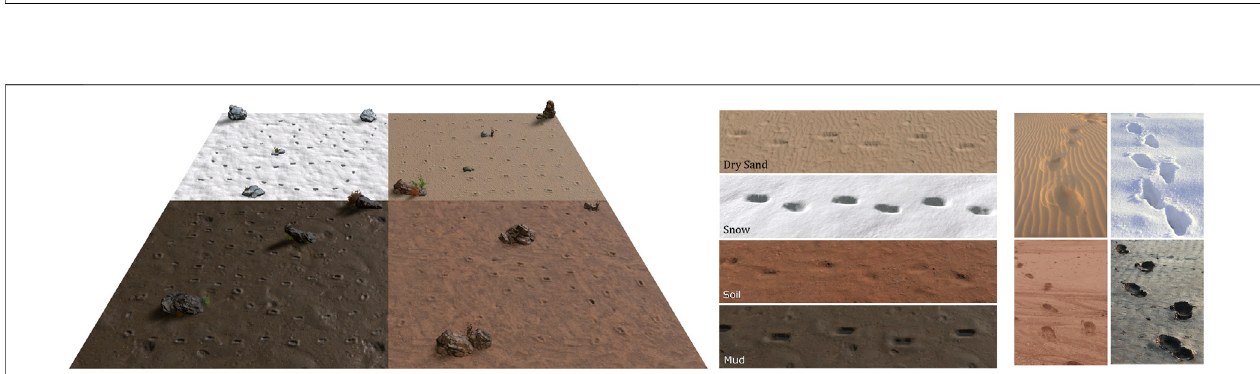
FIGURE 7 | (A) Test scenario of our terrain deformation model for asphere falling from a fi xed distanceon soft ground. (B) Pure compressive material deformation for different weight sphere mass m and Young ’ s modulus E . (C) Lateral accumulation for semi-incompressible material for various Poisson ’ s ratio ] and Young ’ s modulus E .